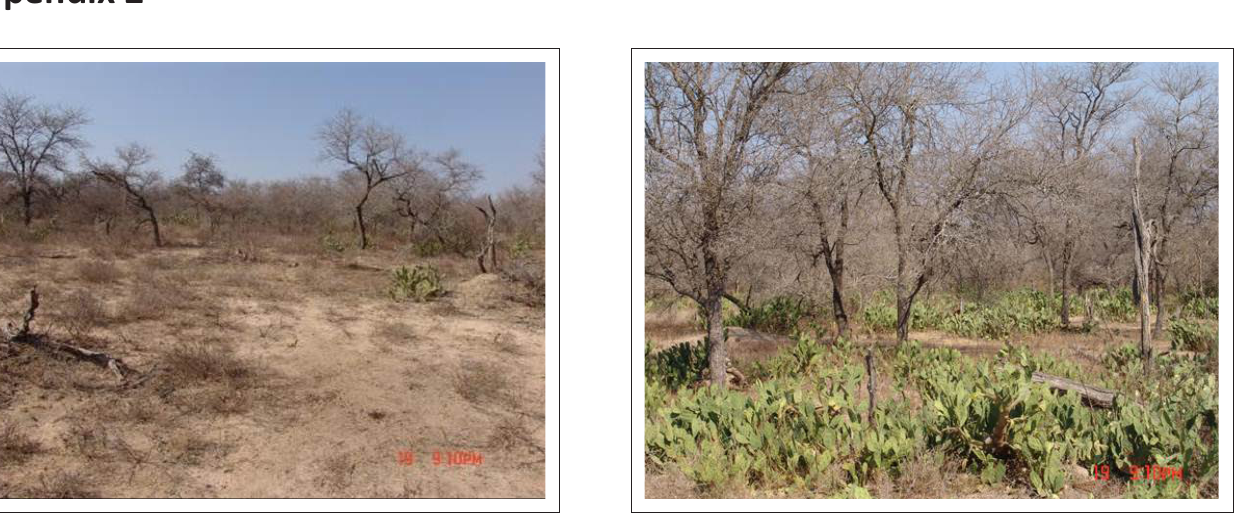
FIGURE 3: Invasion with between 31 % and 50 % cover.